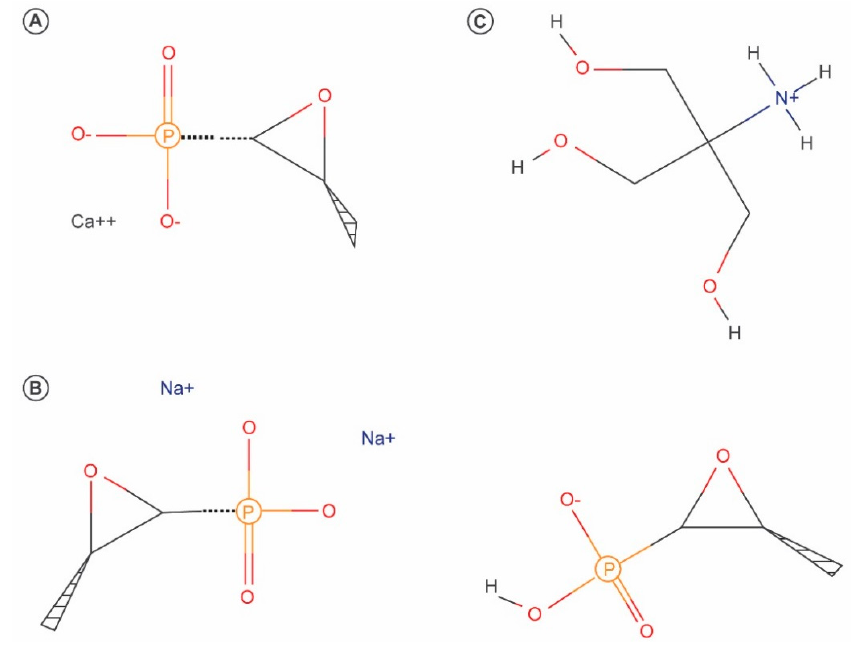
Figure 2. Chemical structures of fosfomycin calcium ( A ), fosfomycin disodium ( B ) and fosfomycin tromethamine ( C ).